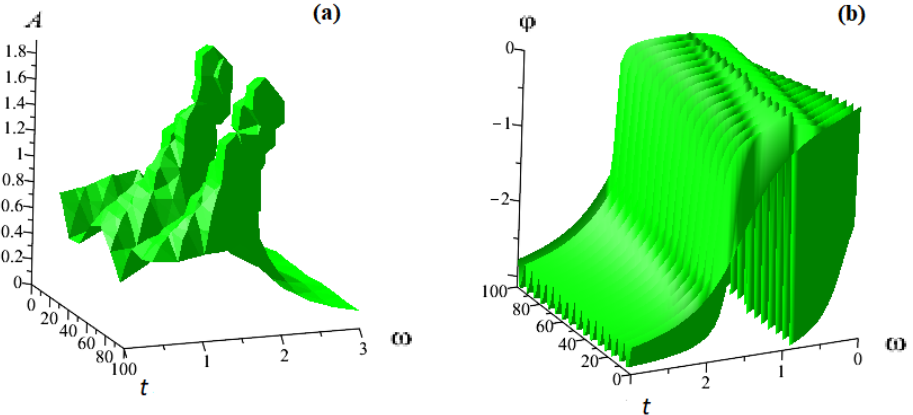
Figure 14. ( a ) AFC and ( b ) PFC for operator (2) with order q ( t ) = 0.8cos ( 0.5 t ) .